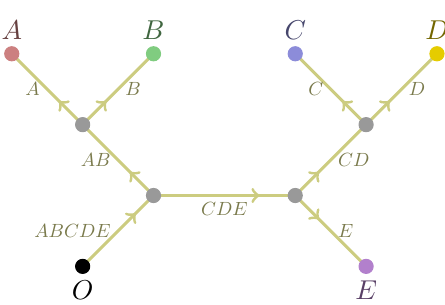
Figure 5. An example of a simple tree graph G 5 , with explicit edge labeling and orientation